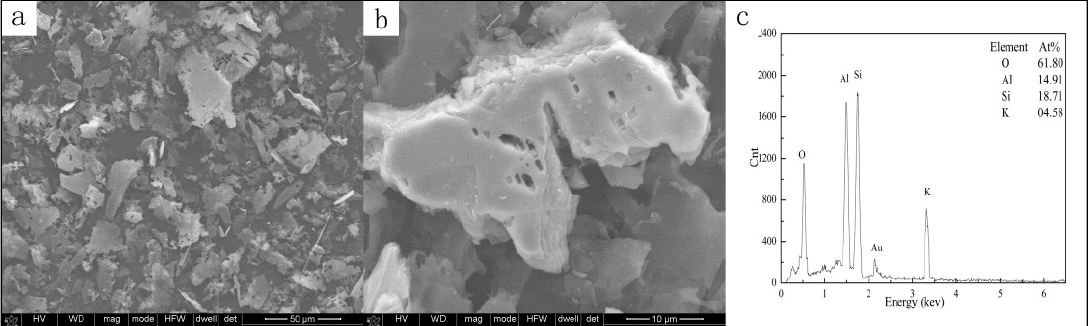
Figure 9. SEM-EDS analysis of alkali leached residue: ( a ) Magnification is 1000 times and scale bar is 50 μ m; ( b ) Magnification is 5000 times and scale bar is 10 μ m; ( c ) EDS (Experiment condition: alkali